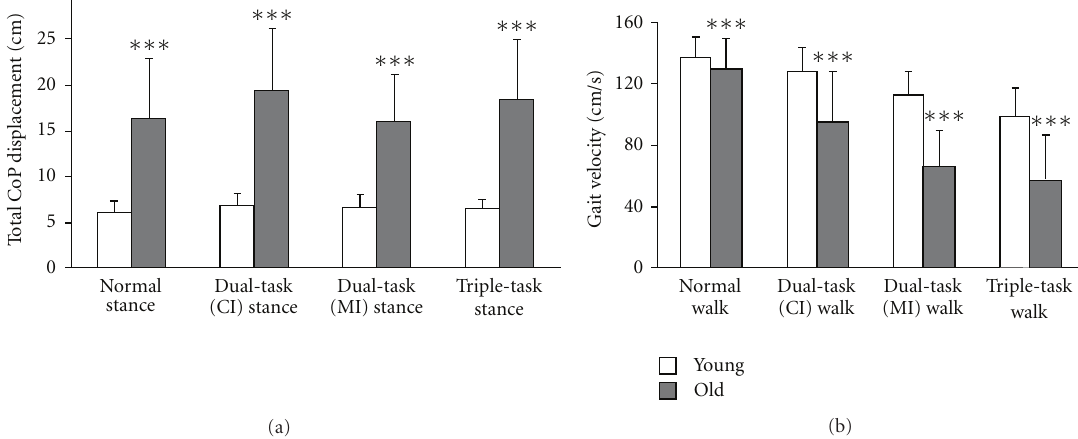
Figure 2: Age-related di ff erences in normal and multitask balance performance. (a) CoP displacement during standing. (b) Gait velocity during walking. Young di ff erent from old: ∗∗∗ P < 0 . 001. CoP: center of pressure, CI: cognitive interference task, MI: motor interference task. Adapted from Granacher et al. [18,